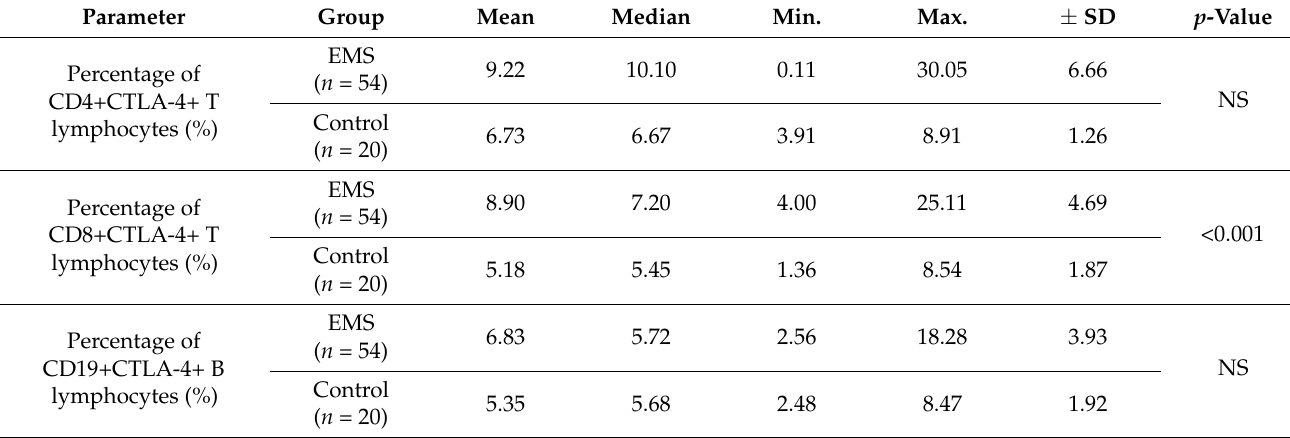
Table 1. Percentage of CD4+ T lymphocytes, CD8+ T lymphocytes and CD19+ B lymphocytes expressing the CTLA-4 antigen among lymphocytes in peripheral blood in the group of patients with endometriosis and the control group.